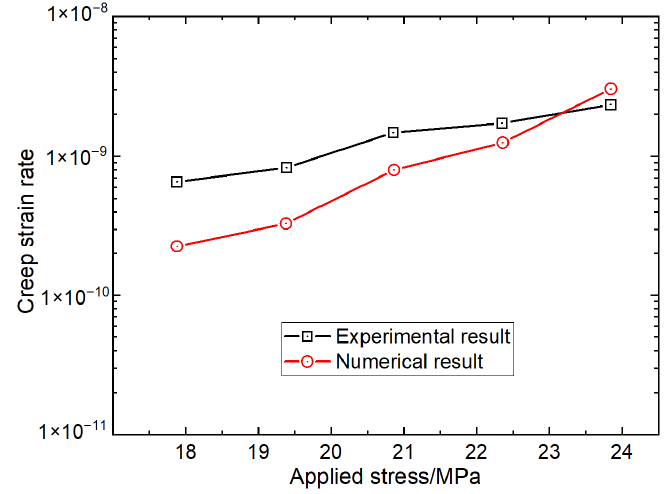
Figure 17. Relationships between creep strain rate and applied stress in the multi-step creep tests in the laboratory and in numerical simulation.